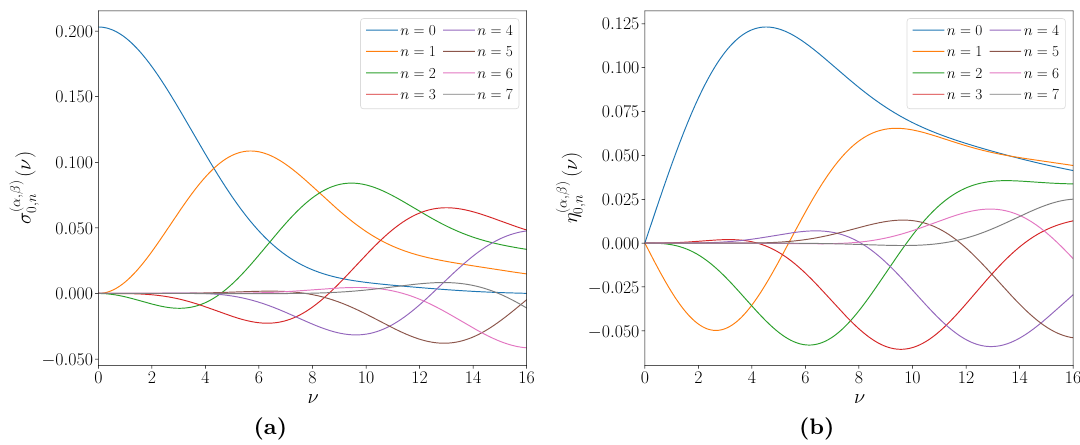
Figure 13. The eight lowest-order σ ( α,β ) (a) and η ( α,β ) (b) polynomials for an arbitrarily chosen 0 ,n 0 ,n basis α = 0 . 125 and β = 2 . 85 . Each polynomial features an extremum in a range of Ioffe-time accessible in our lattice calculation, and asymptotically approaches zero for ν → ∞